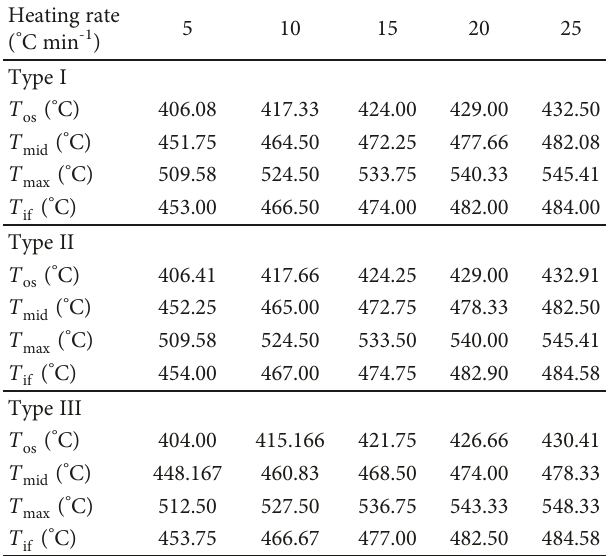
Table 4: Thermal stability and properties for the materials investigated